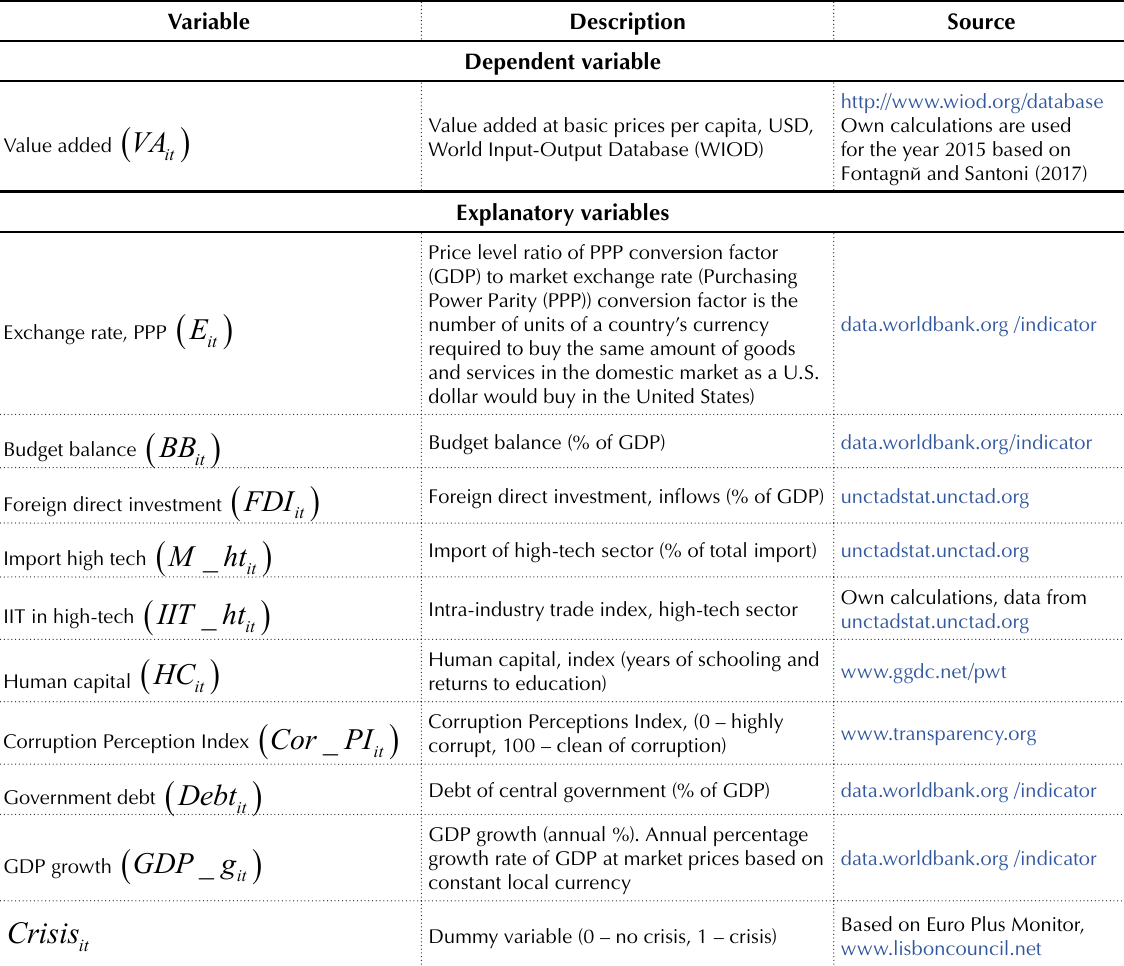
Source: Authors’ own